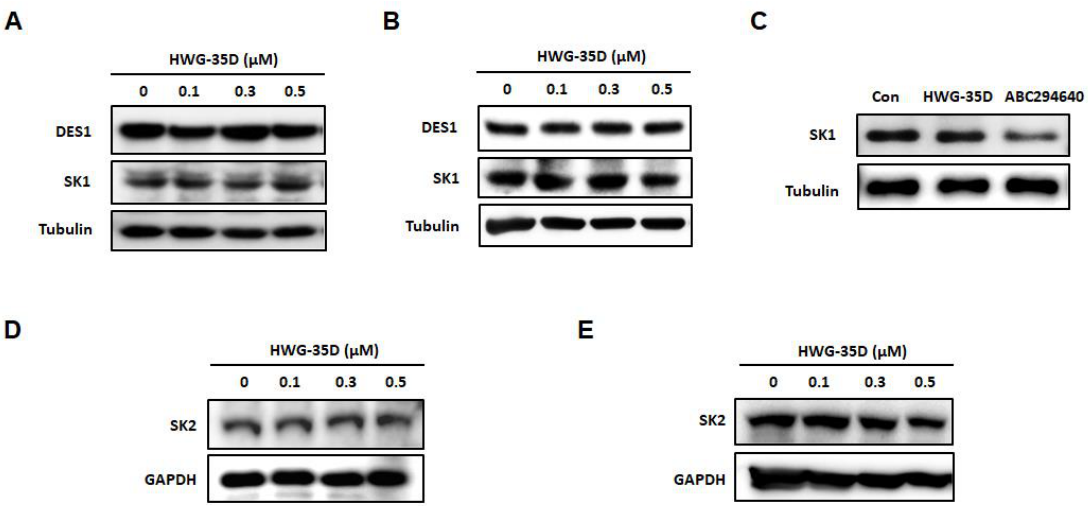
Figure 1. HWG-35D does not alter dihydroceramide desaturase 1 (DES1), sphingosine kinase (SK) 1, and SK2 protein levels. ( A and D ) MCF-7 and ( B and E ) NIH3T3 cells were incubated with HWG-35D at the indicated concentrations for 24 h. ( C ) Total CD4 + T cells isolated from murine spleen were treated with HWG-35D (300 nM) or with ABC294640 (25 μM) for 24 h. Western blot analysis was performed to examine the degradation of DES1, SK1 and SK2. The representative images are shown of three independent